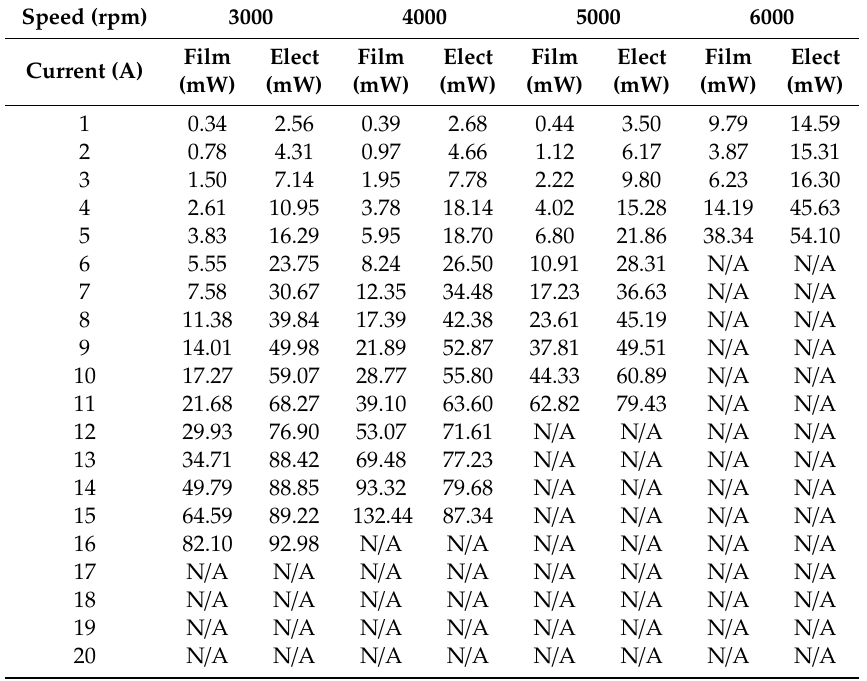
N / A N / A N / A N / A N / A